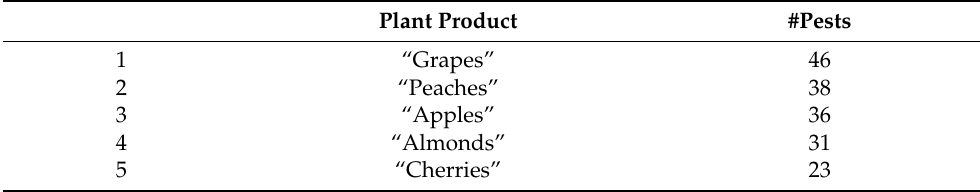
Table 1. Plant products and number of associated pests.